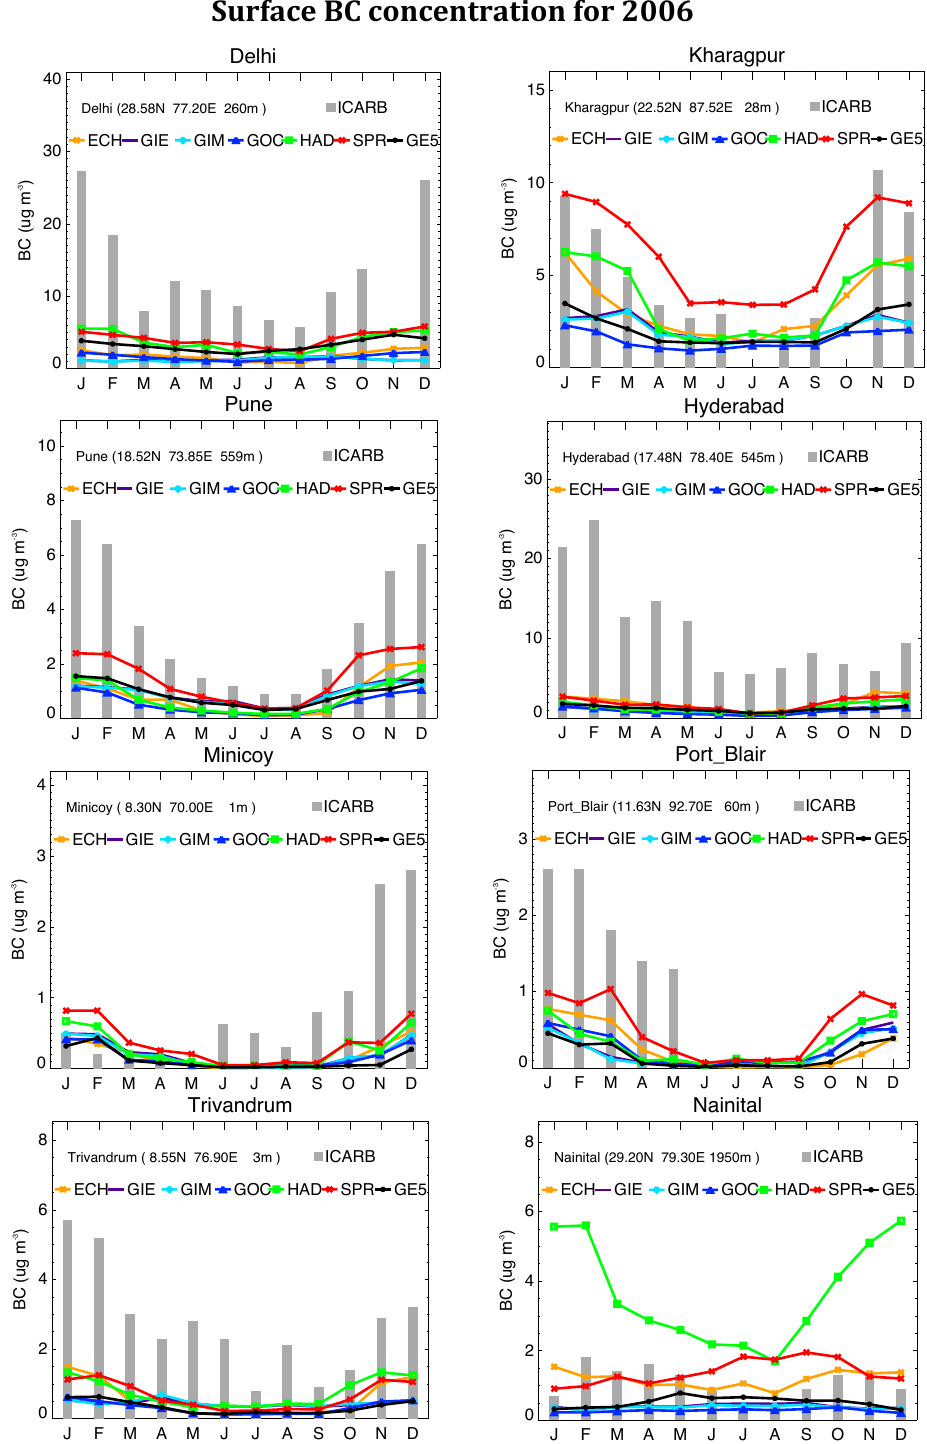
Figure 9. Monthly mean surface BC concentration at eight ICARB stations in 2006 (units: µgm − 3 ). Gray bar represents measurement from ICARB and thin lines represent seven